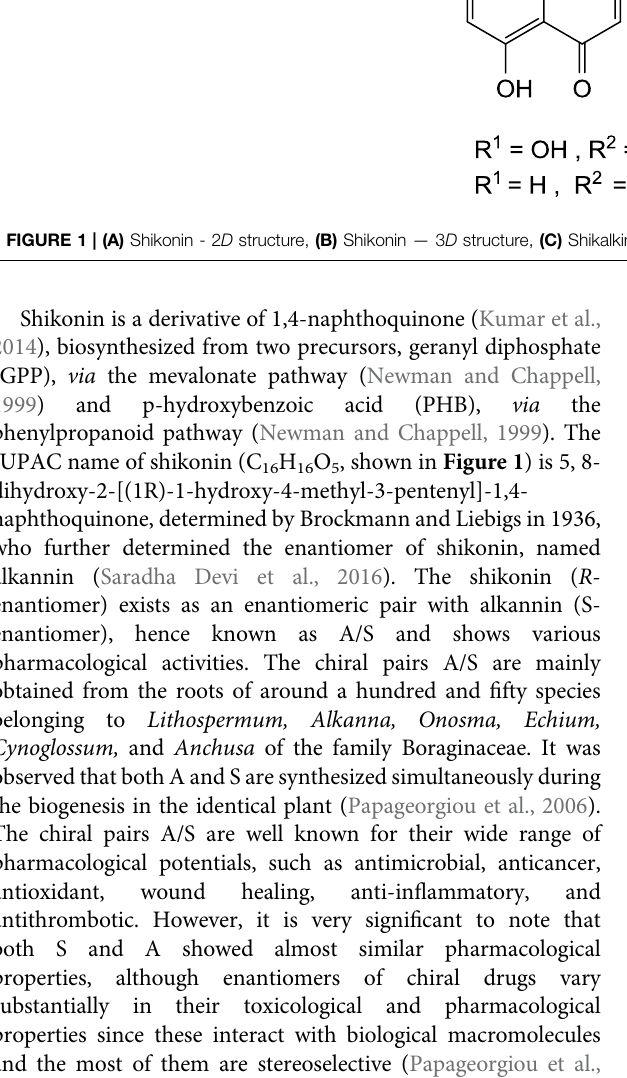
Frontiers in Pharmacology |